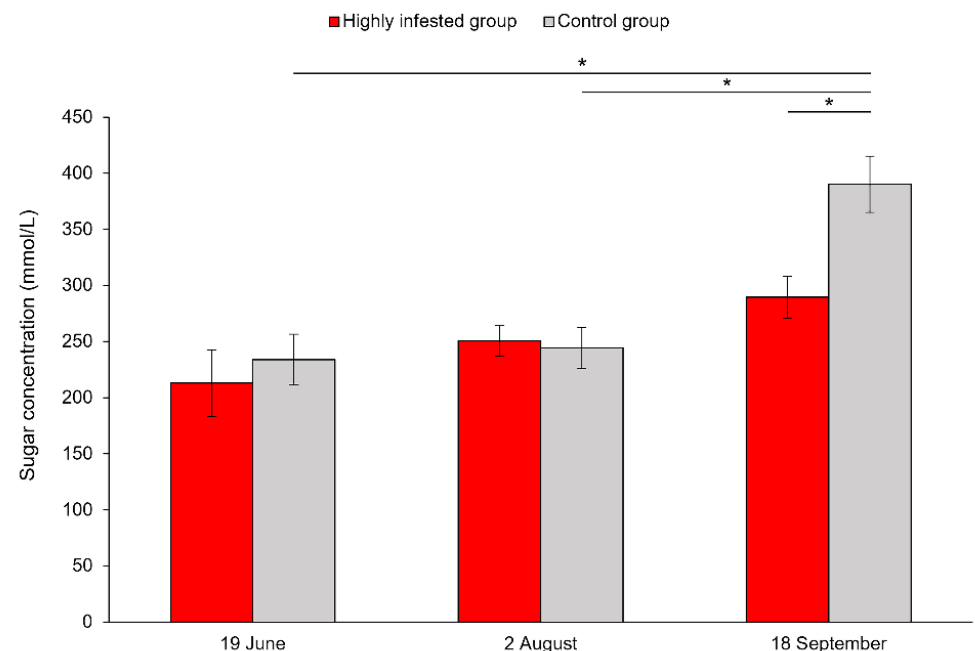
Figure 2. Sugar (glucose and trehalose) concentrations in hemolymph through time. On 18 Septem- ber 2019, highly infested hives showed a significantly lower concentration of combined sugars in hemolymph compared to control hives (*, p < 0.001, a priori contrasts in